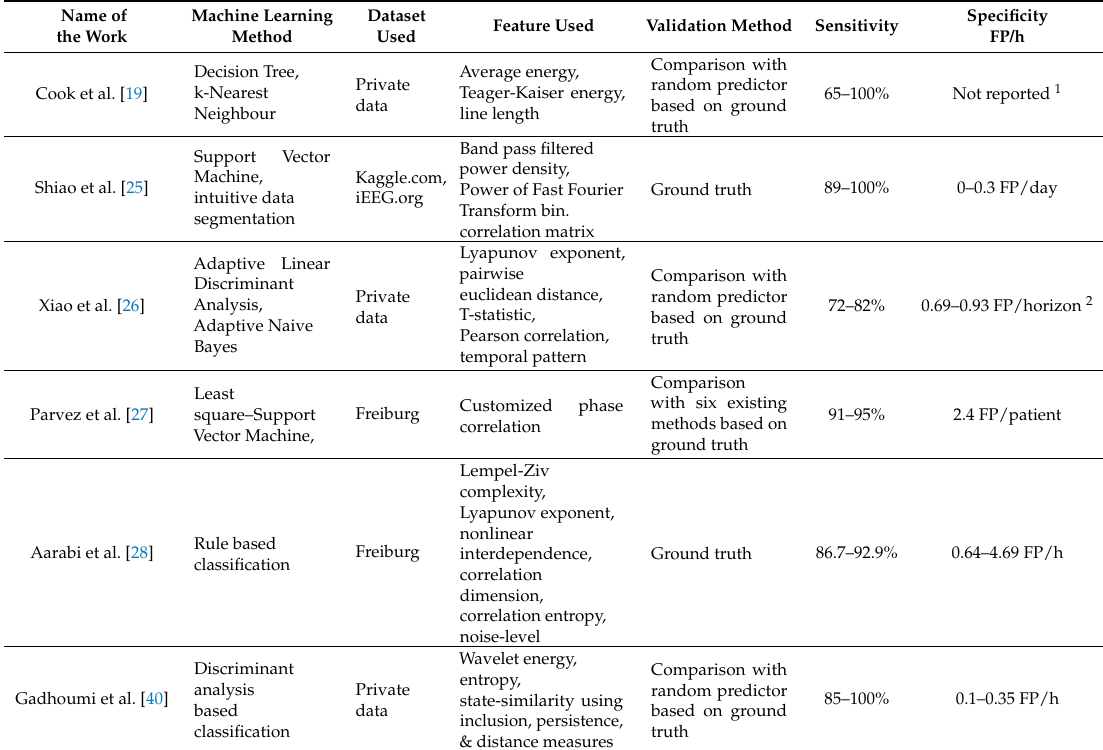
Table 2. A selective summary of seizure prediction